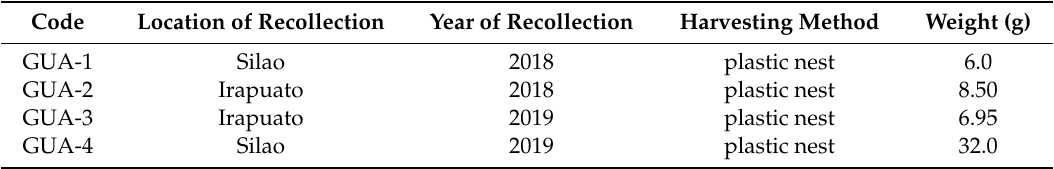
Table 1. Location of recollection, harvesting method, and weight